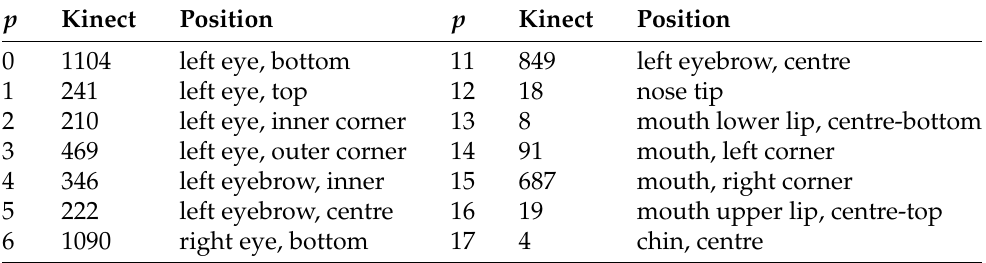
Table 5. Indices of points of interest, p is an internal index